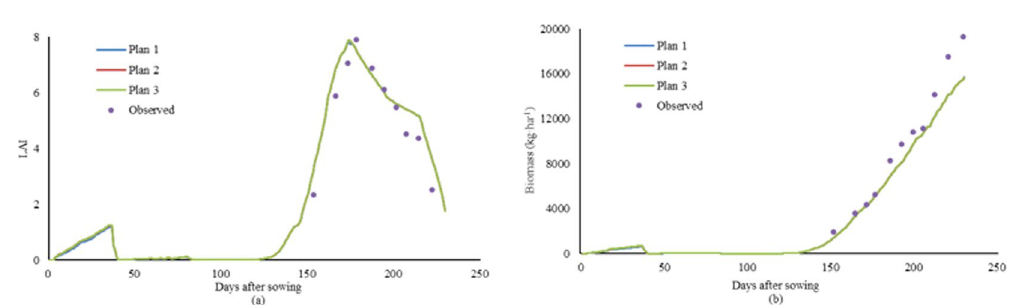
Figure 2. Dynamic changes of simulated LAI ( a ) and biomass ( b ) for winter wheat by the modified DSSAT models during 2015–2016 in Xinxiang, Henan Province, China. Notes: Original K C is in the current version of DSSAT 4.6 for Penman-Monteith method, calculated by Eq. 17. Modified K C is suggested by DeJonge et al . 30 , calculated by Eq. 19. Observed K C came from local